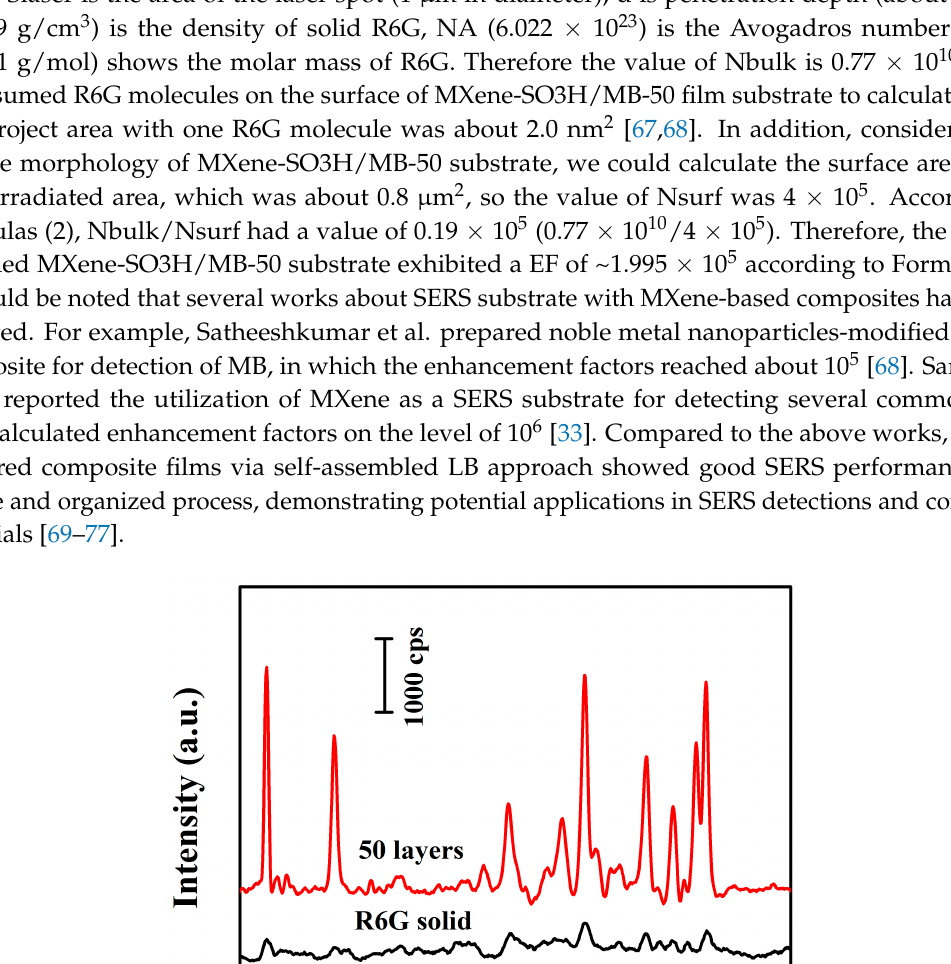
Figure 12. Surface enhanced Raman scattering (SERS) spectra of 10 − 3 M R6G on the MXene-SO3H/MB-50 films on silicon.